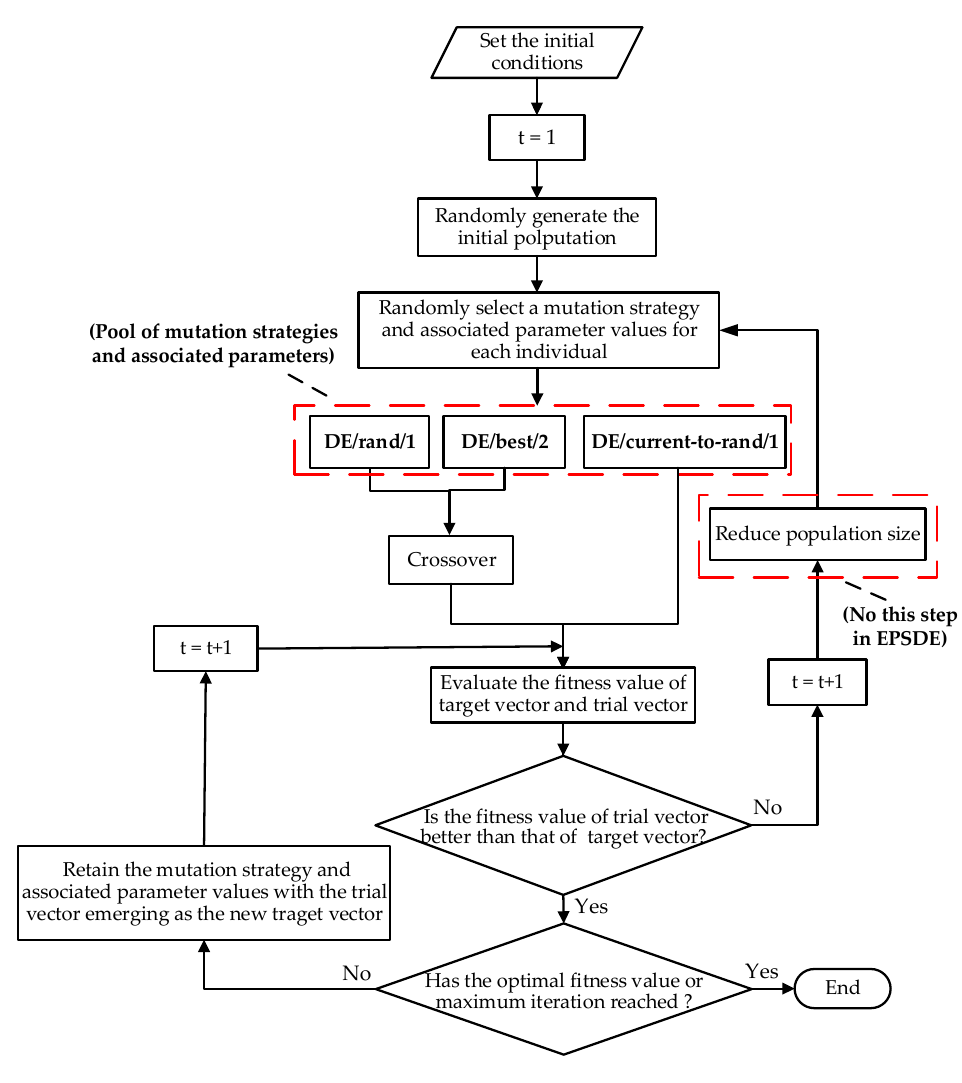
Figure 7. Flow chart of EPSDE and L-EPSDE method.